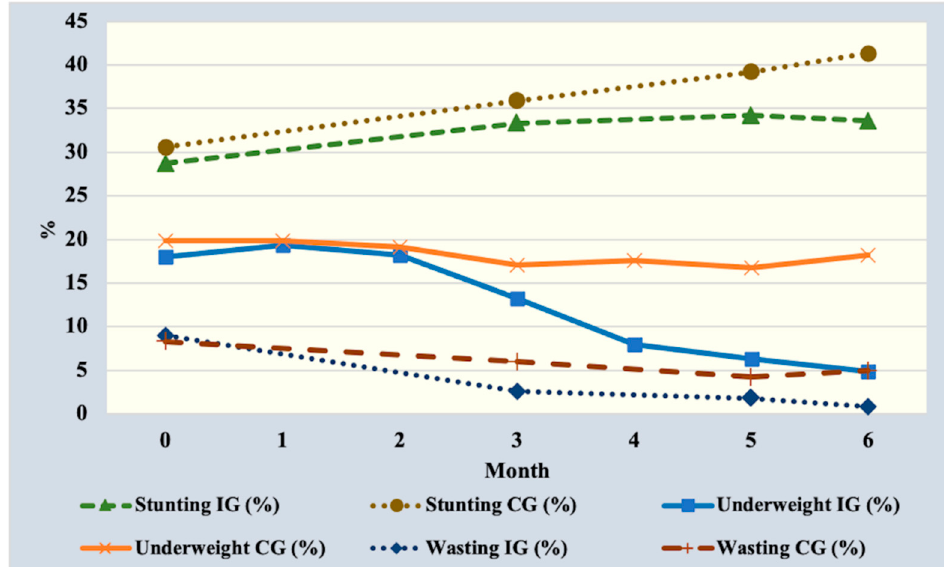
Figure 2. Trend in proportion of children in each nutritional status group from baseline to end line, over 6 months. IG = Intervention group; CG = control